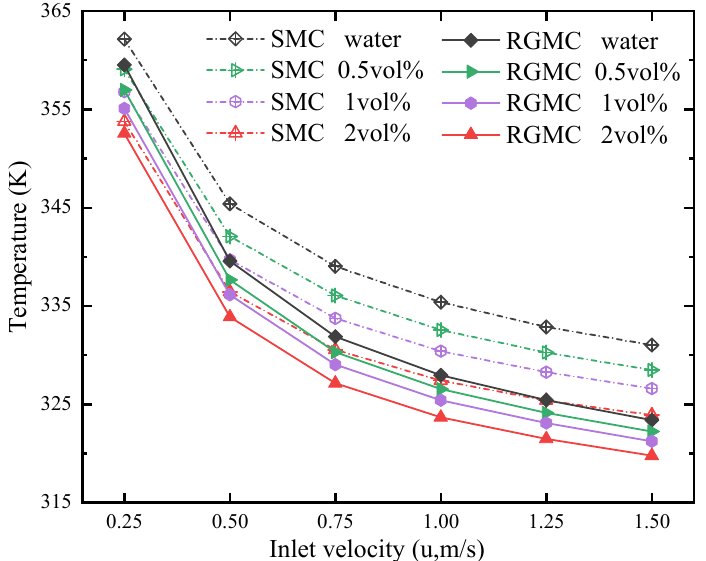
Figure 5. T max variation at different inlet velocities and volume fractions.